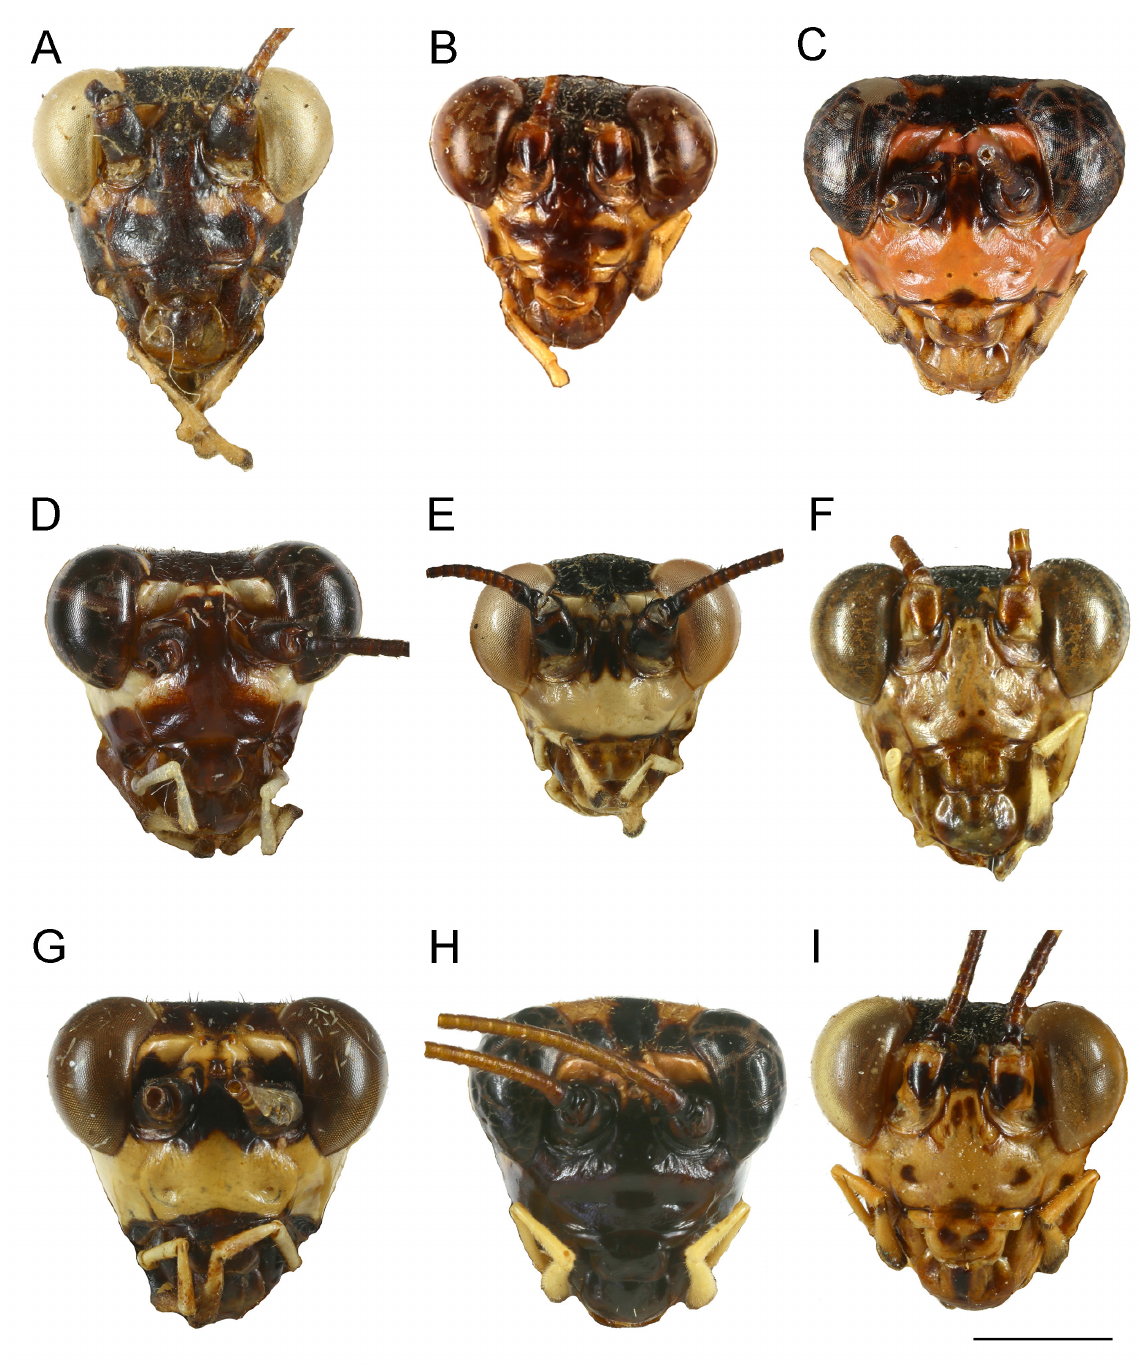
Fig. 10. Face in anterior view. A . Nisitrus brunnerianus Saussure, 1878. B . N. crucius Robillard &